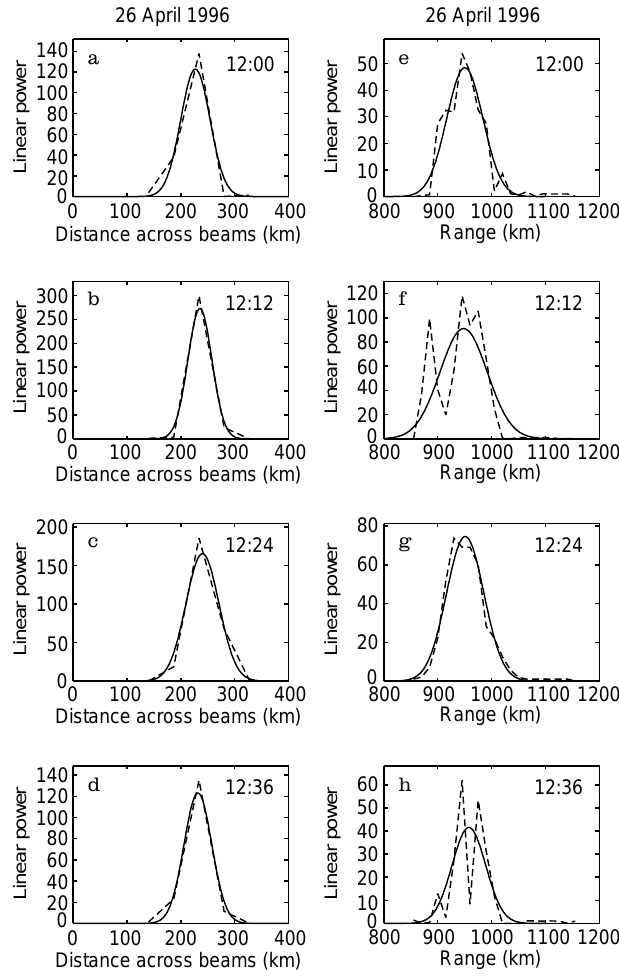
Fig. 7a–h. Data from CUTLASS Finland for 26 April 1996, between 1200 and 1240UT. Panels a to d illustrate Gaussian profiles fitted to azimuthal data. Panels e to h present Gaussian profiles fitted to range data